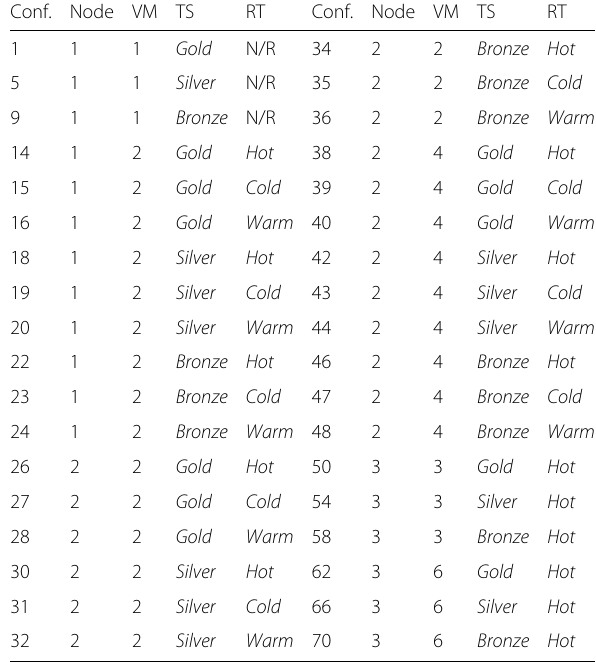
Table 5 SPN Warm-Standby parameters